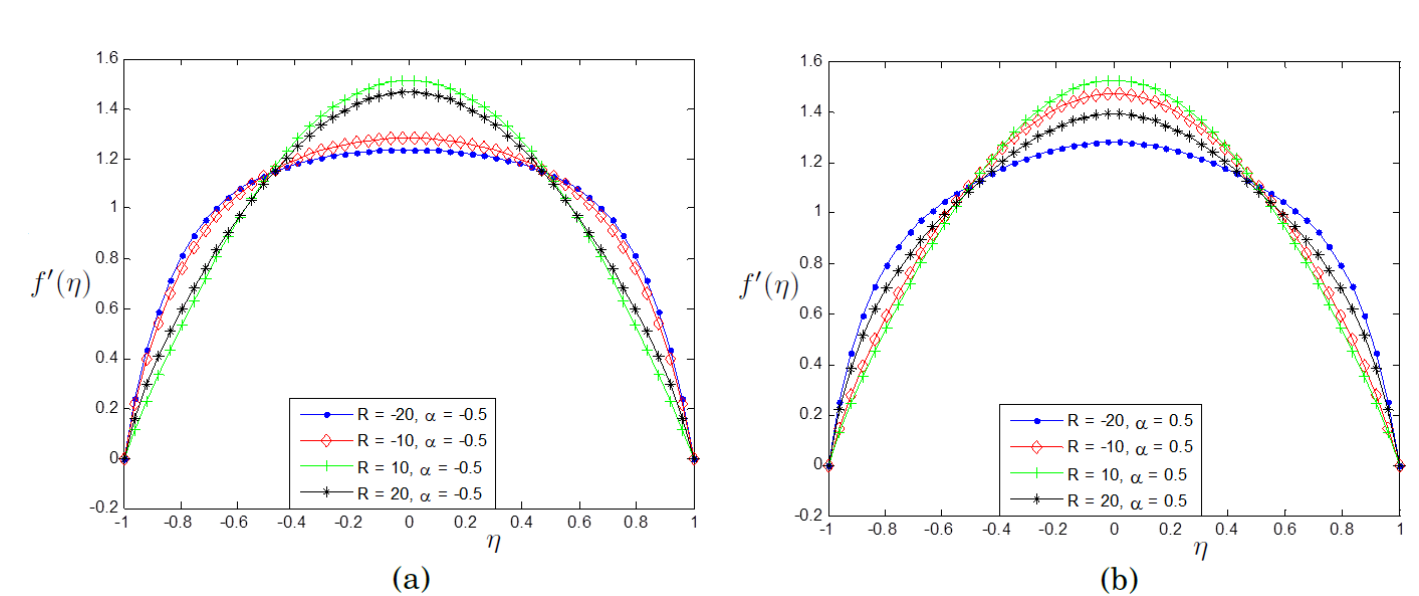
Figure 3: Variation of f (cid:48) ( η ) for different expansion and contraction ratio, α and Reynold number. Effects of the Reynolds number of permeation and dimensionless rate of dilation on mean fluid velocities are depicted in Figure 1. Effects of Re , on dimensionless axial velocity are displayed in Figures 1(a)-(d), 2(a)-(d), 3(a) and 3(b). The